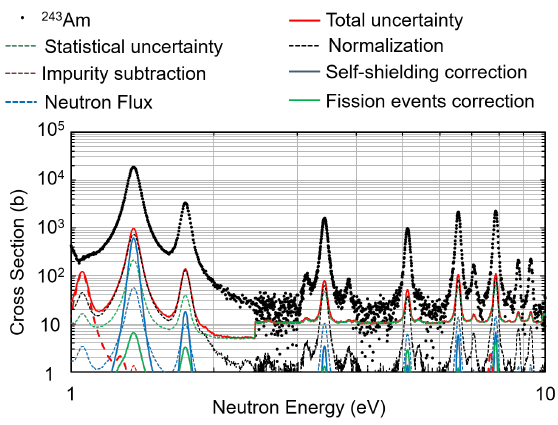
Figure 8. Deduced capture cross section of 243 Am and with a comparison to the deduced uncertainties in the neutron energy range from 1 to 10 eV.